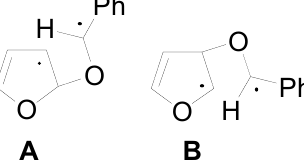
Figure 6. Possible biradical intermediates in the reaction of furan with